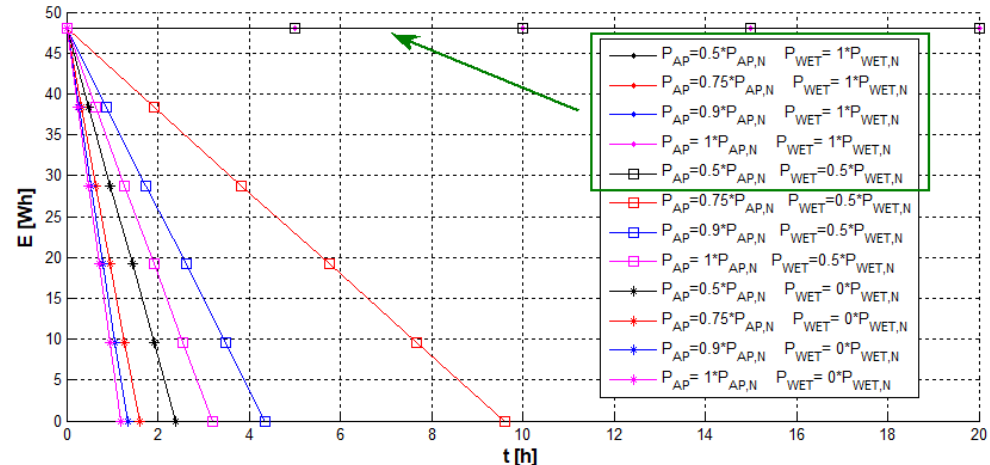
Figure 6. Results of a simplified simulation of a change in the remaining energy in the battery during operation, depending on the access point’s load and the extracted power from the WET system ( P WET,N = 50 W, P AP,N = 40 W).